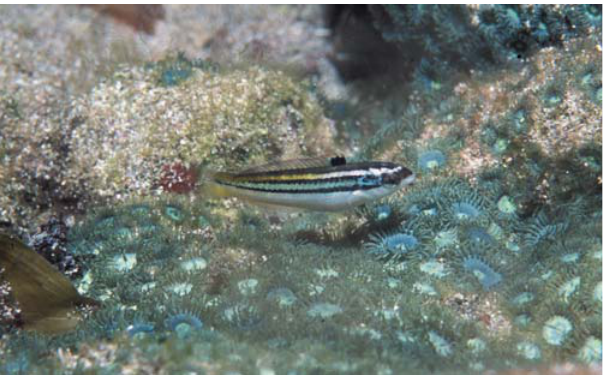
Fig. 1. A small Noronha wrasse ( Thalassoma noronhanum ) individual, displaying the characteristic colour pattern of the initial phase.